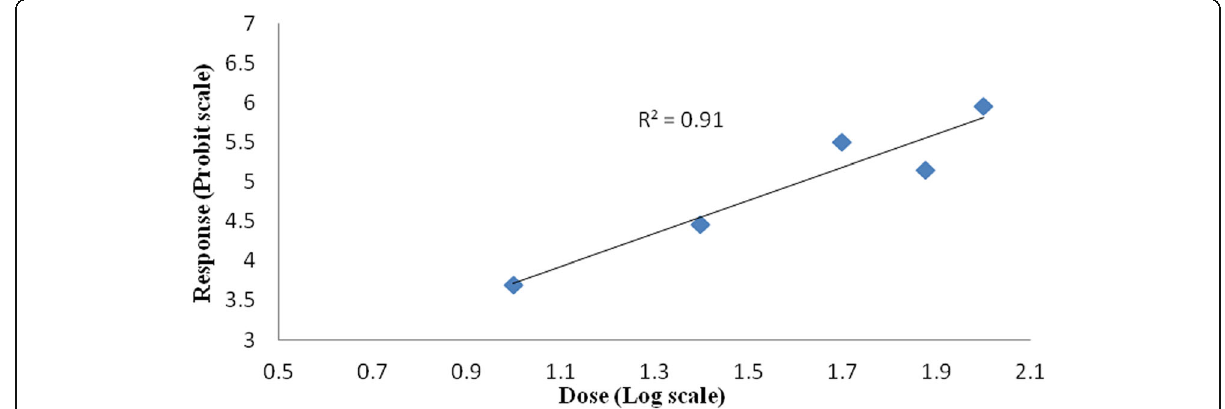
Fig. 2 Mortality (Probit-transformed) of Agrotis segetum treated with different concentrations of Steinernema carpocapsae